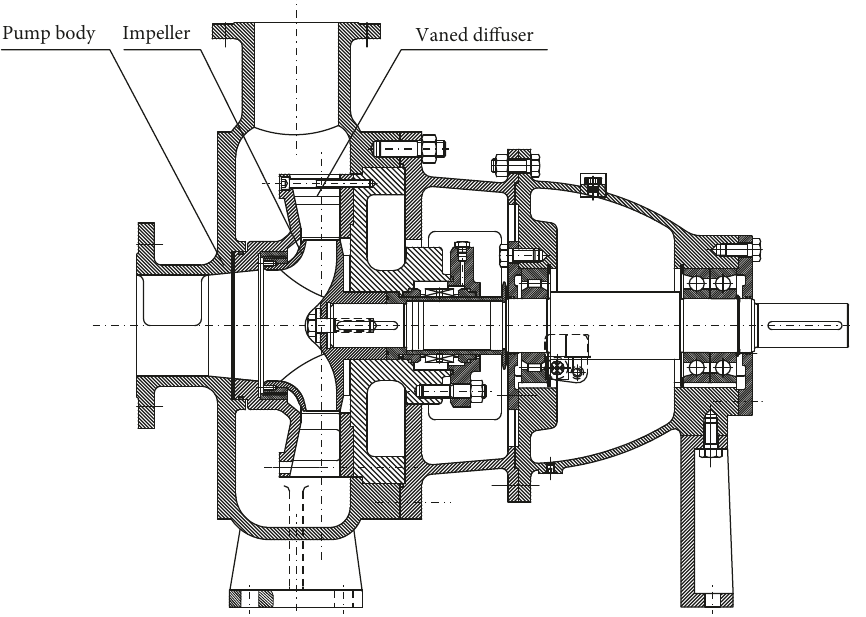
Figure 1: Structure of the centrifugal pump with vaned diffuser.